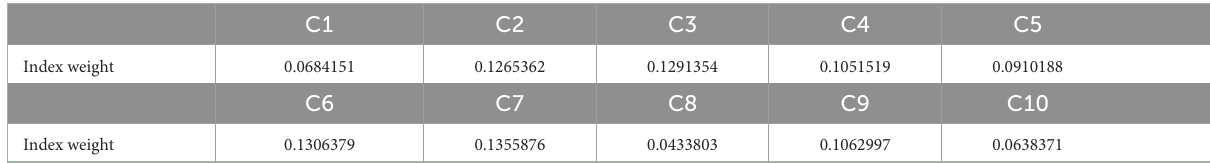
TABLE 2 Index weight.